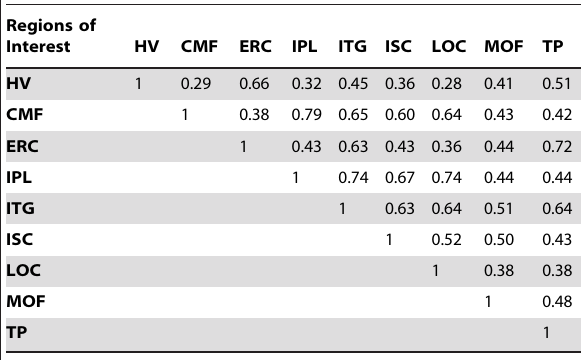
Table 2. Correlation results between cortical thickness of eight neocortical ROIs and total hippocampal volume in all ADNI participants (n=724).